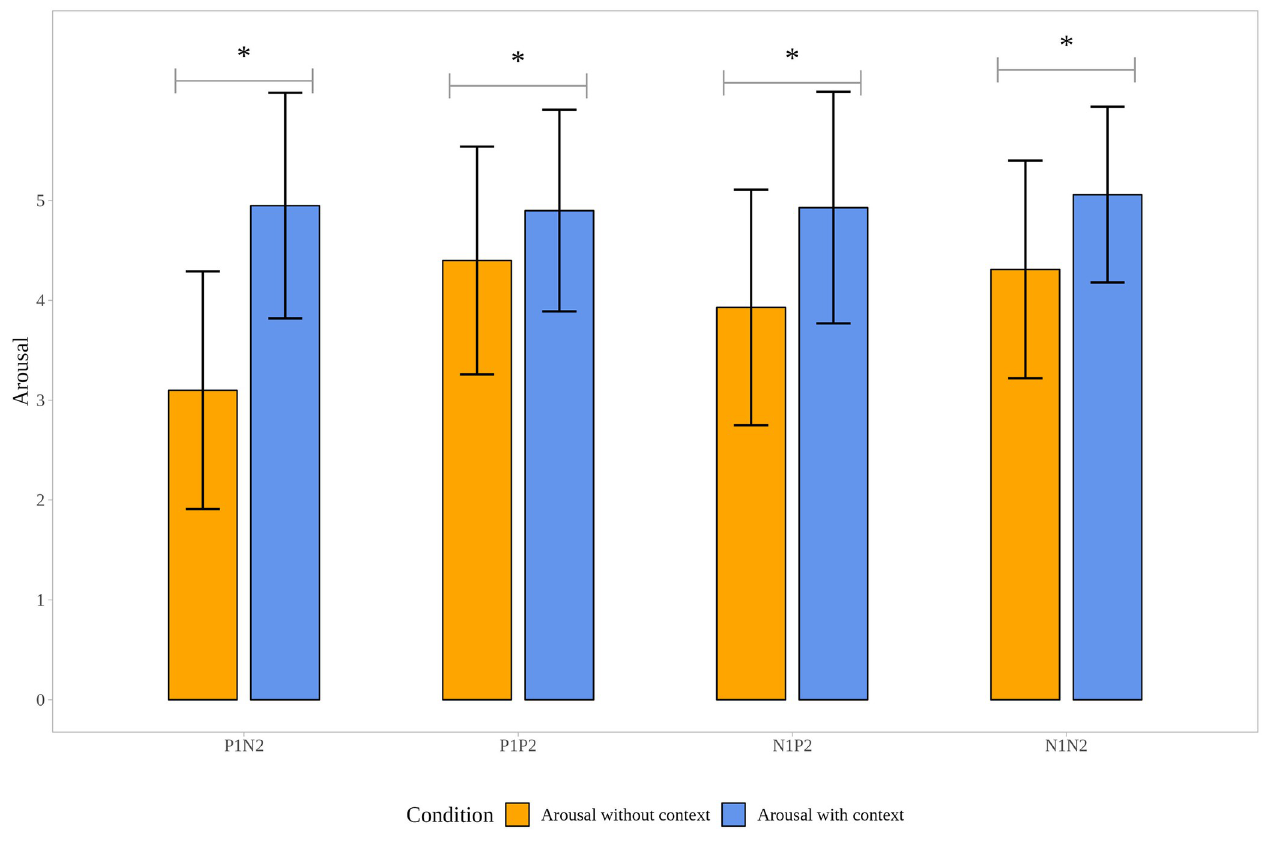
Fig 4. Changes in arousal ratings in the post-task. Note. P1: First picture of the picture pairs is positive. N1: First picture of the picture pairs is negative. P2: Second picture of the picture pairs is positive. N2: Second picture of the picture pairs is negative. � p < .001.